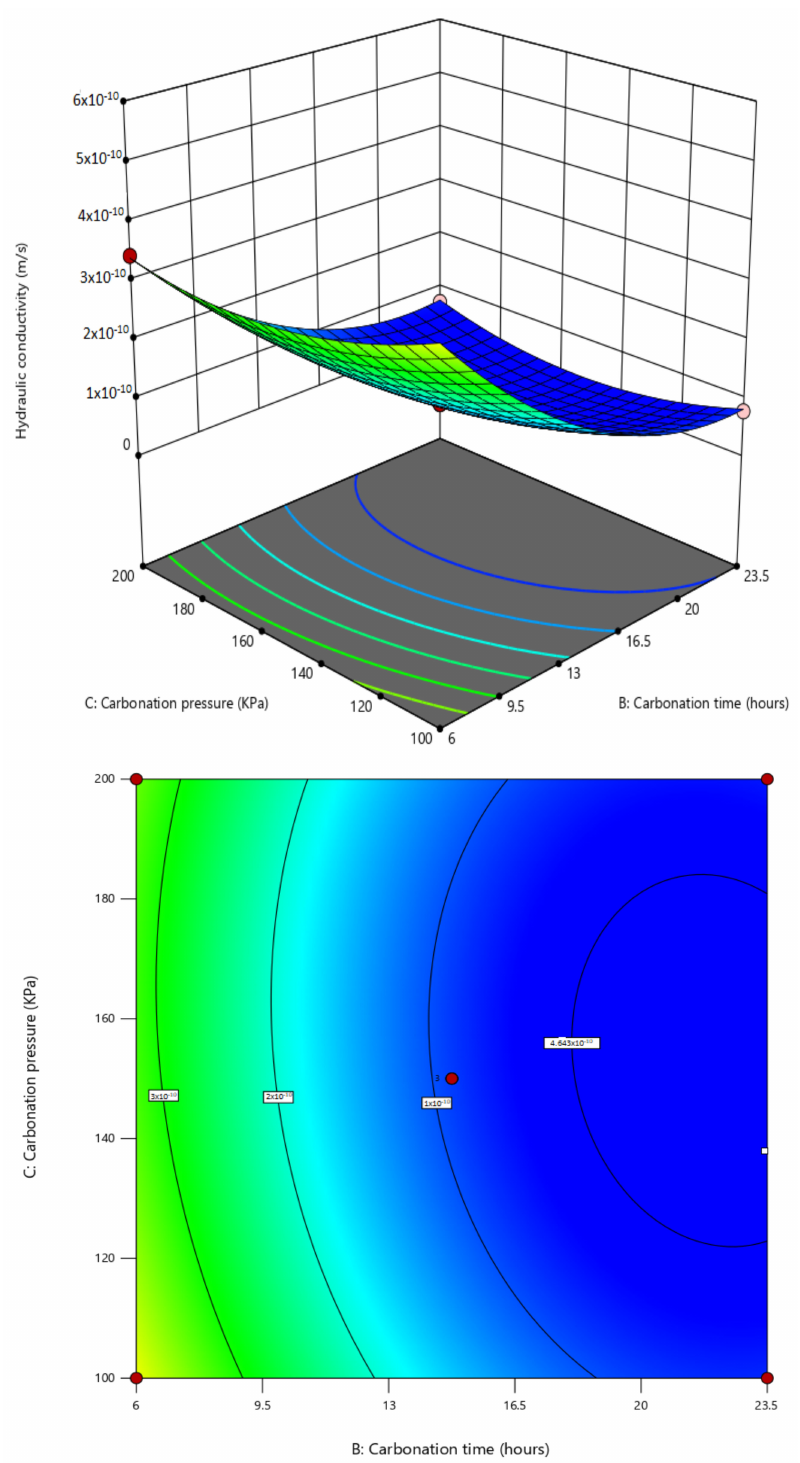
Figure 10. Response surface and contour plots demonstrating the interactive effects of carbonation time and carbonation pressure on the hydraulic conductivity while keeping olivine content at central